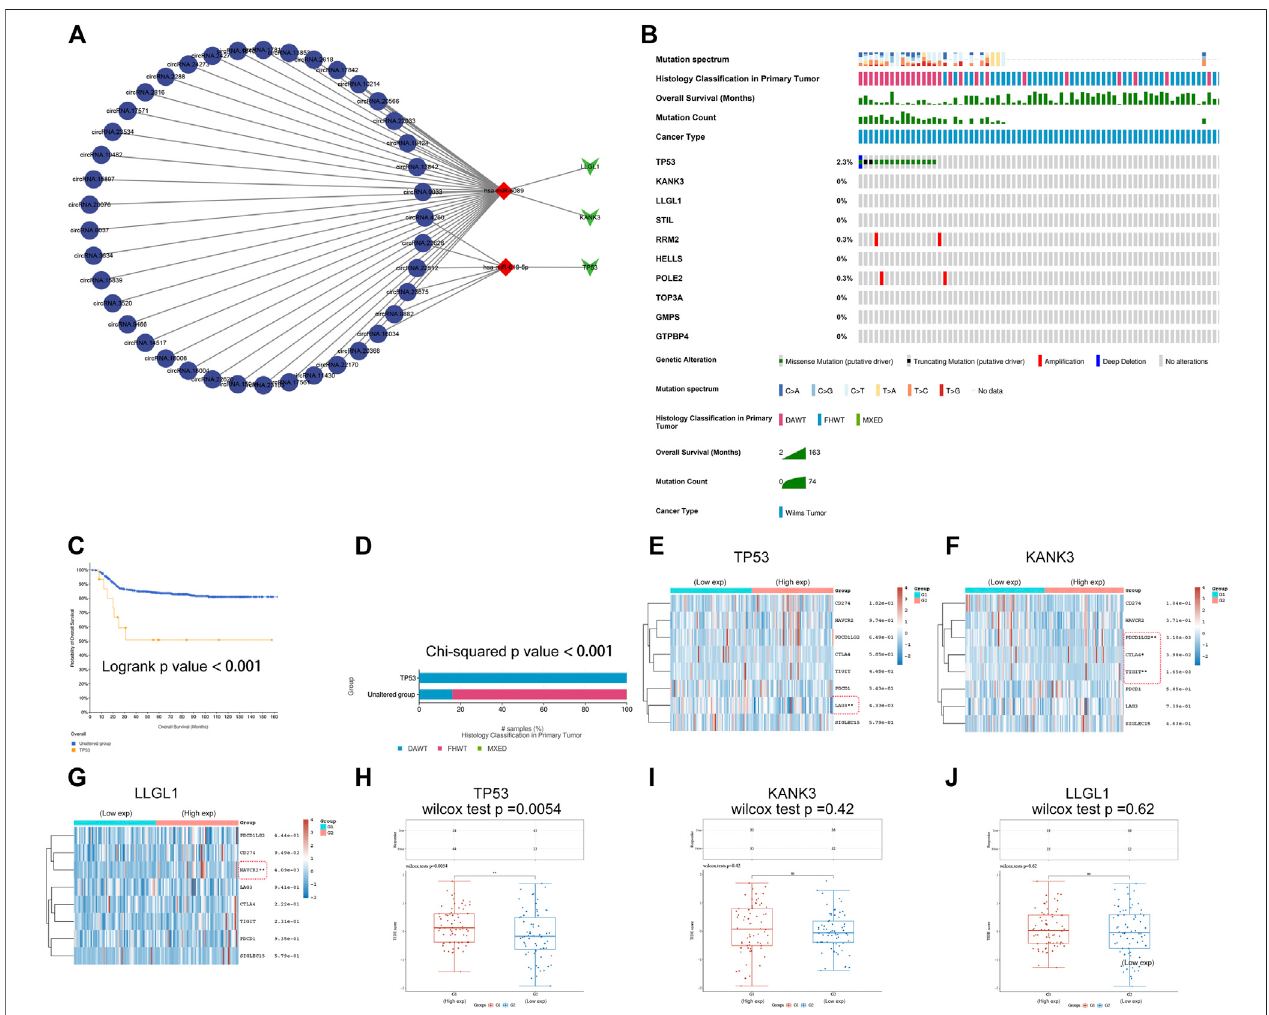
FIGURE 9 | Establishment of a ceRNA sub-network and analysis ofmutational landscape of gene signature and its effect on immune response. (A) A ceRNA sub- network based on the three-gene prognostic signature. (B) The mutational pro fi les of gene signature in Wilms tumor, data of genetic alteration were obtained from the cBioPortal for Cancer Genomics (https://www.cbioportal.org). (C) Comparison of survival between patients with and without TP53 mutations. (D) Comparison of pathological types between patients with and without TP53 mutations. DAWT: anaplasia type, FHWT: favorable histology type. (E-G) Comparison of gene expressionofimmunecheckpoint-relatedgenesbetweenthehigh-andlow-expressionTP53,KANK3,orLLGL1groups.Eachrowrepresentsoneimmunecheckpoint- related gene and each column represents one sample; Red indicates high expression and green represents low expression of immune checkpoint-related genes. (H-J) ComparisonofTIDEscorebetweenthehigh-andlow-expressionTP53,KANK3,orLLGL1groups.TumorImmuneDysfunctionandExclusion(TIDE) scorewasusedto predict potential tumor therapeutic response with immune checkpoint inhibitors. *: p < 0.05, **: p < 0.01, ***: p < 0.001.